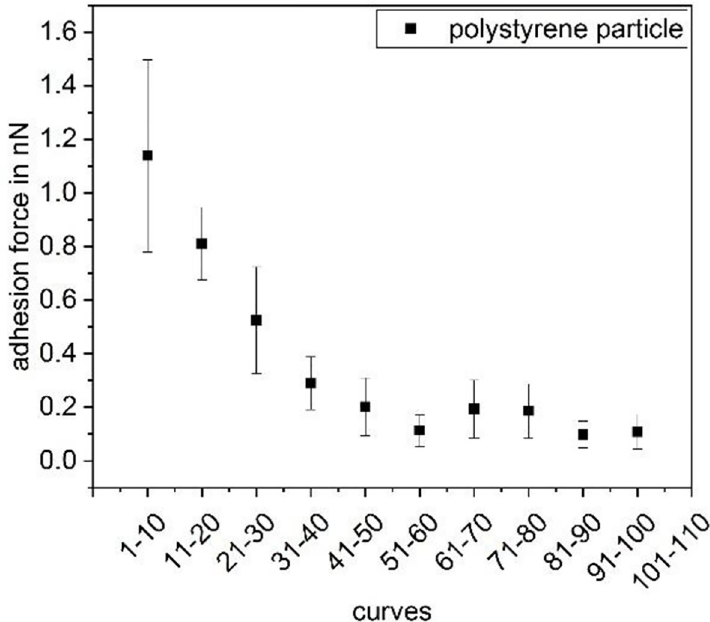
Fig 7. Adhesion force of a polystyrene particle as a function of the number of force-distance curves recorded previously.